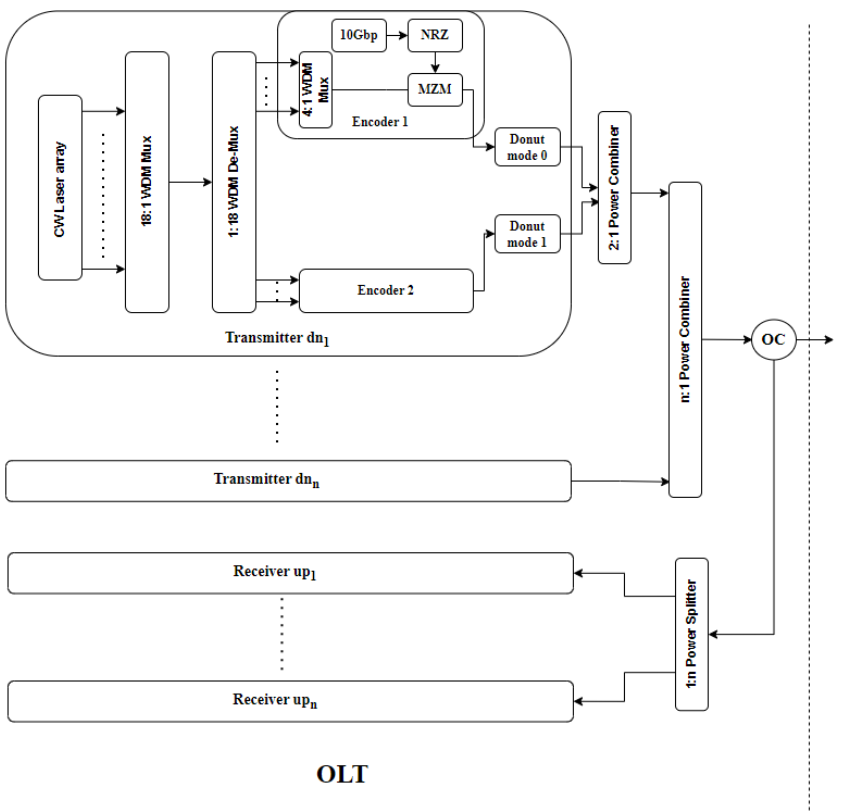
Figure 2. Proposed design of bidirectional MDM-PON system incorporating MWZCC OCDMA code of transmitter section.